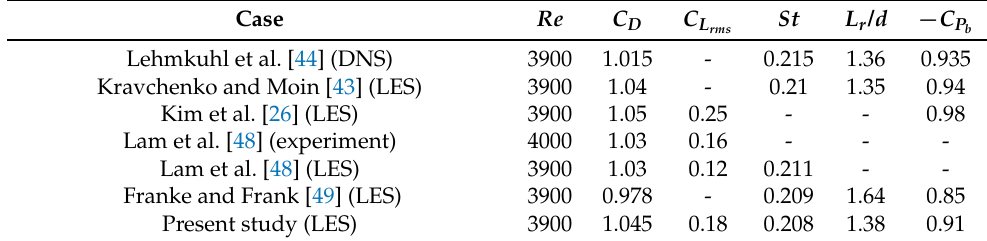
Table 2. Flow statistics for turbulent flow over a circular cylinder without a tab from the present simulation together with those from previous studies. Here, DNS denotes direct numerical